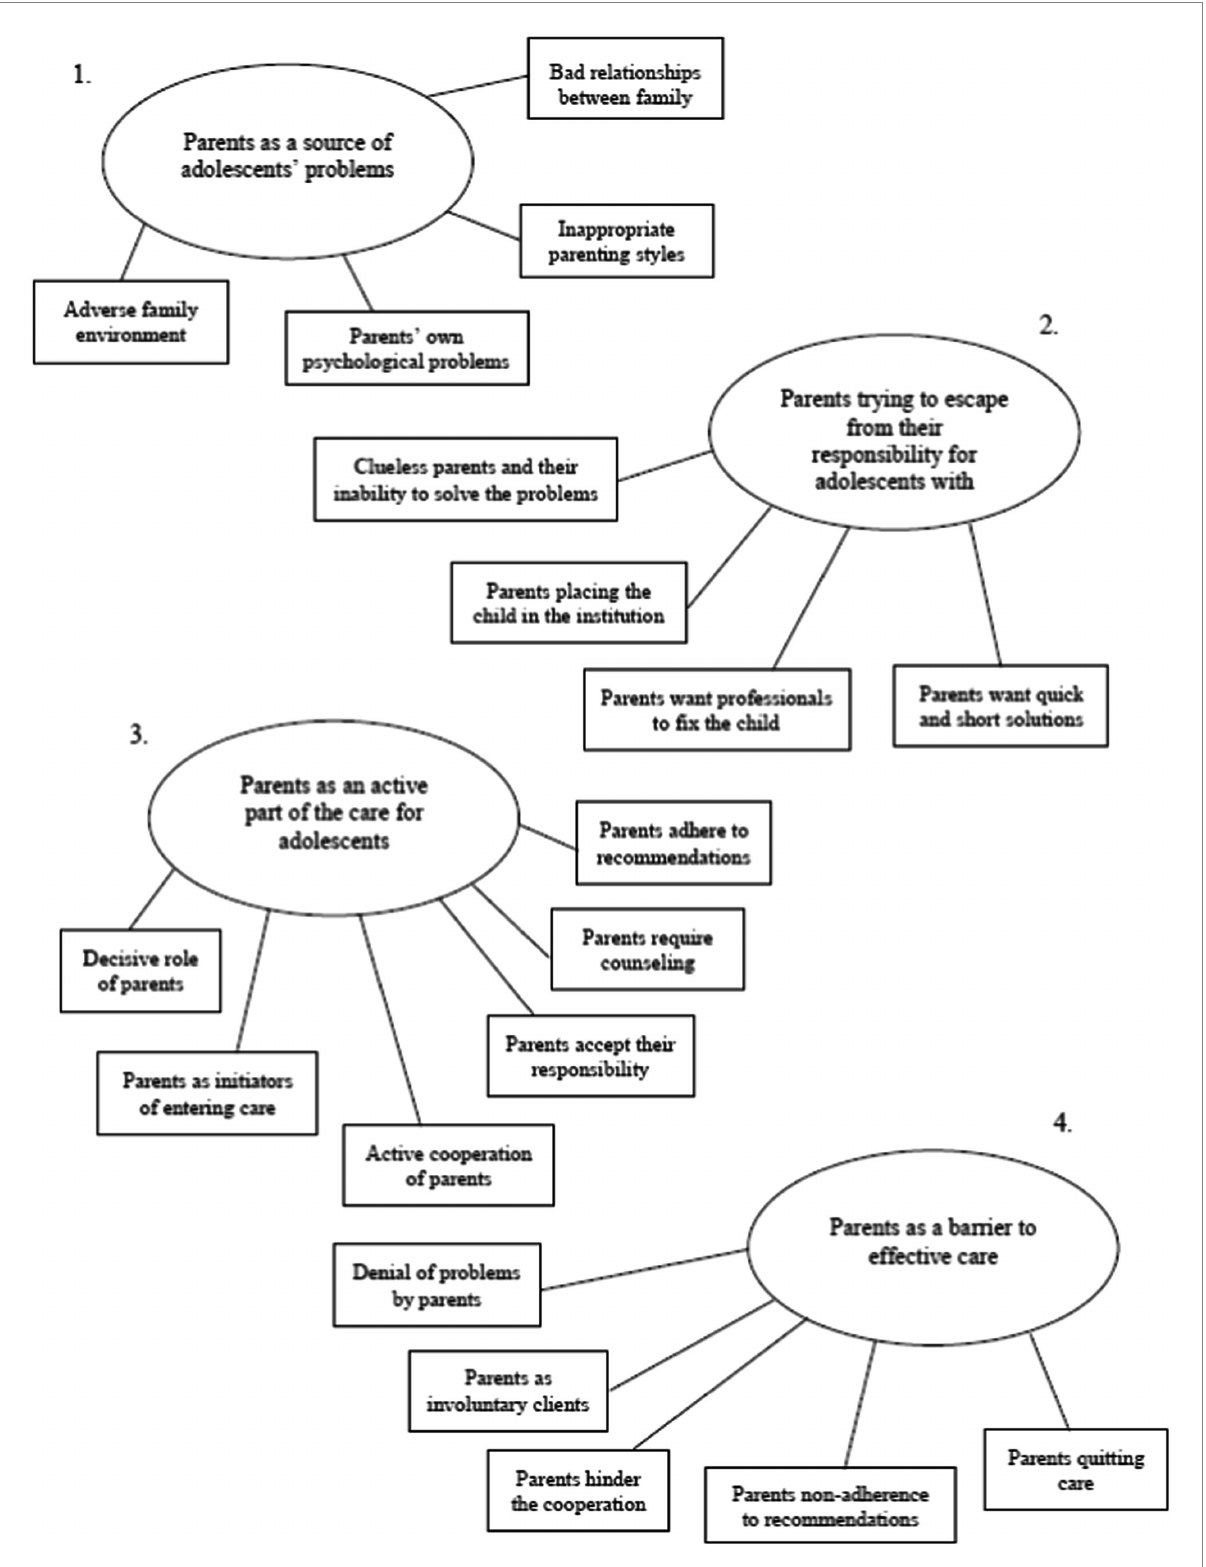
FIGURE 1 The four main themes with subthemes on perceived roles of parents in care identified from of the perspective of care